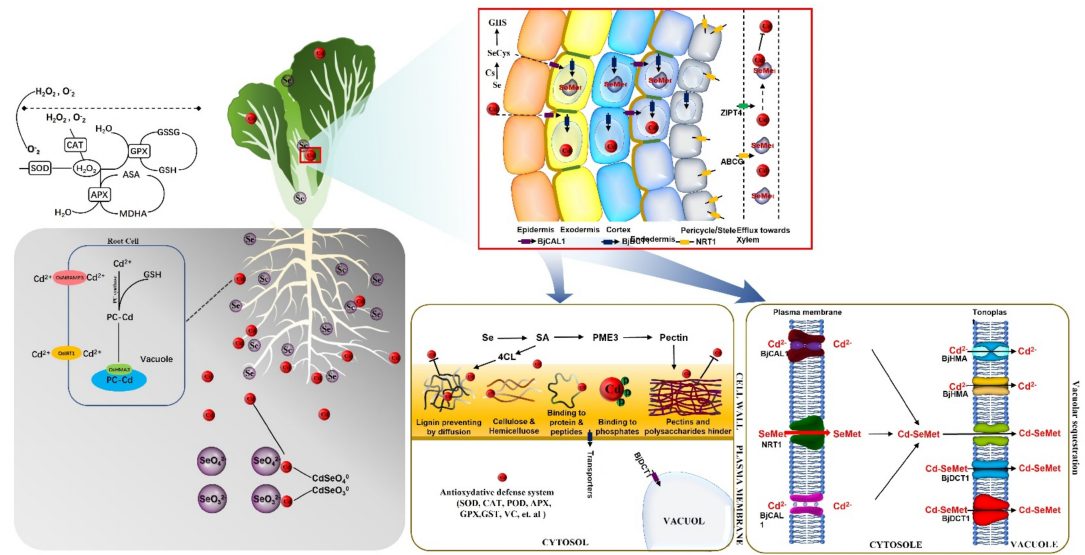
Figure 13. The picture shows the absorption and metabolic transport mechanism of Cd under the influence of Se in B. juncea . Se addition alleviated Cd inhibition of seedling biomass, root length, and chlorophyll. In this study, the mechanism of Se reducing Cd toxicity is summarized as follows: Se reduces the oxidative stress induced by Cd and reduces the content of MDA in cells; Secondly, Se enhanced the adsorption of Cd by pectin and lignin in the root cell wall by promoting SA levels; In addition, in B. juncea , the large amount of synthesis of SeCys and SeMet reduces the transport of Cd to the aboveground part; finally, Se treatment induced the expression of genes, such as MPP , ABCC, and CAL1 , which was helpful to chelate and separate